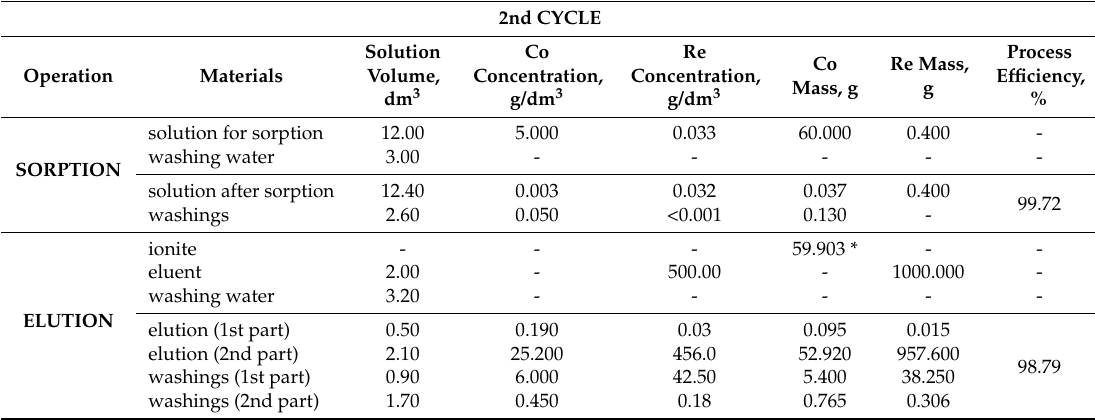
Table 9. Balance for cobalt(II) sorption and elution—2nd cycle. 2nd CYCLE